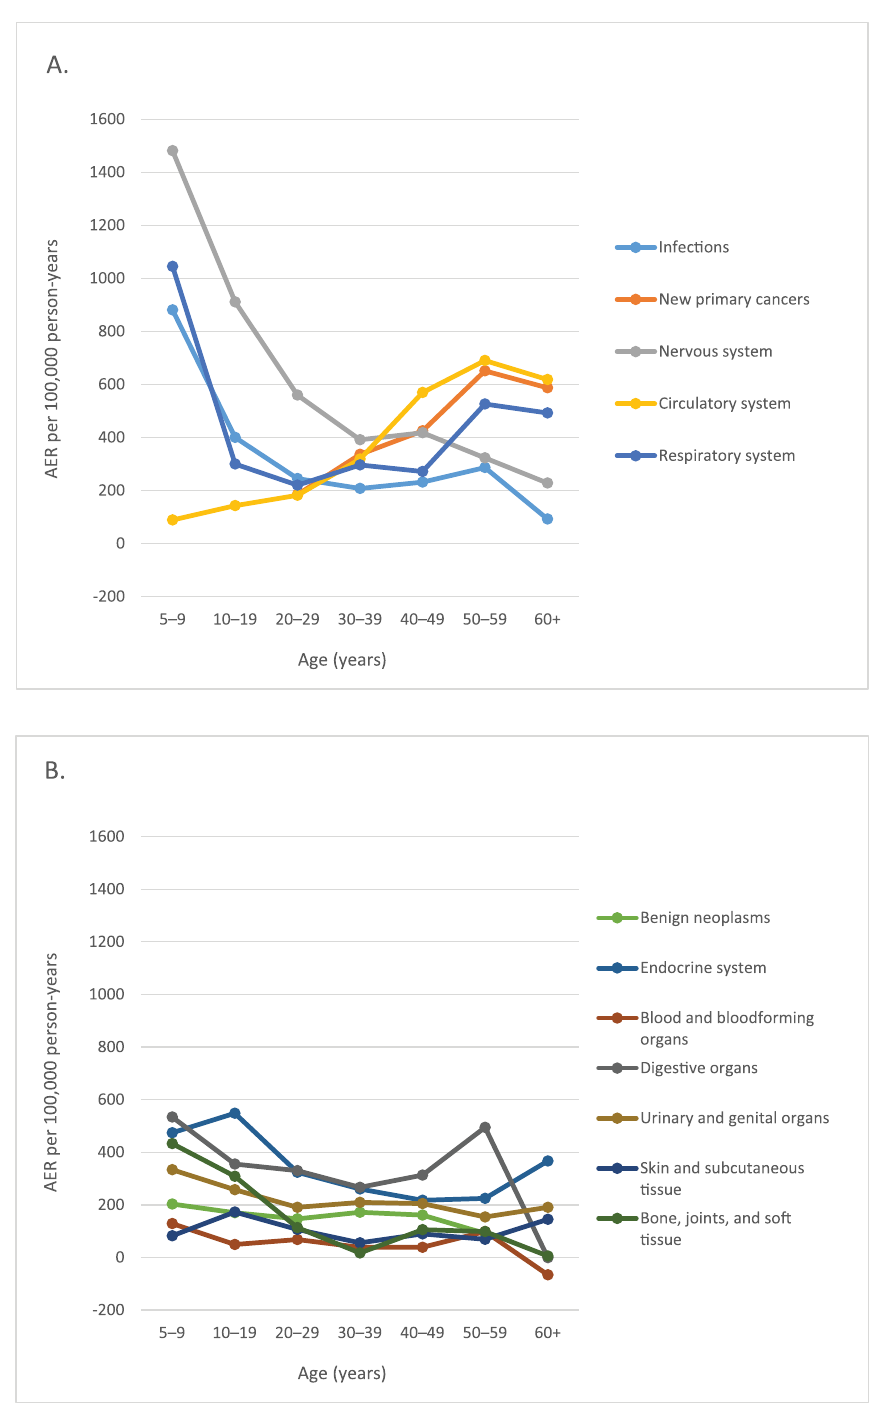
Fig 3. Absolute excessrisks (AERs) for hospitalisation by age (years). (A) Infections, new primary cancers, and diseasesof the nervoussystem, circulatory system, and respiratory system. Note that follow-up for new primary cancers started at age 20 years. (B) Benignneoplasms and diseasesof the endocrine system; blood and blood-forming organs; digestivesystem; urinary and genital system; skin and subcutaneous system; and bone, joints, and soft